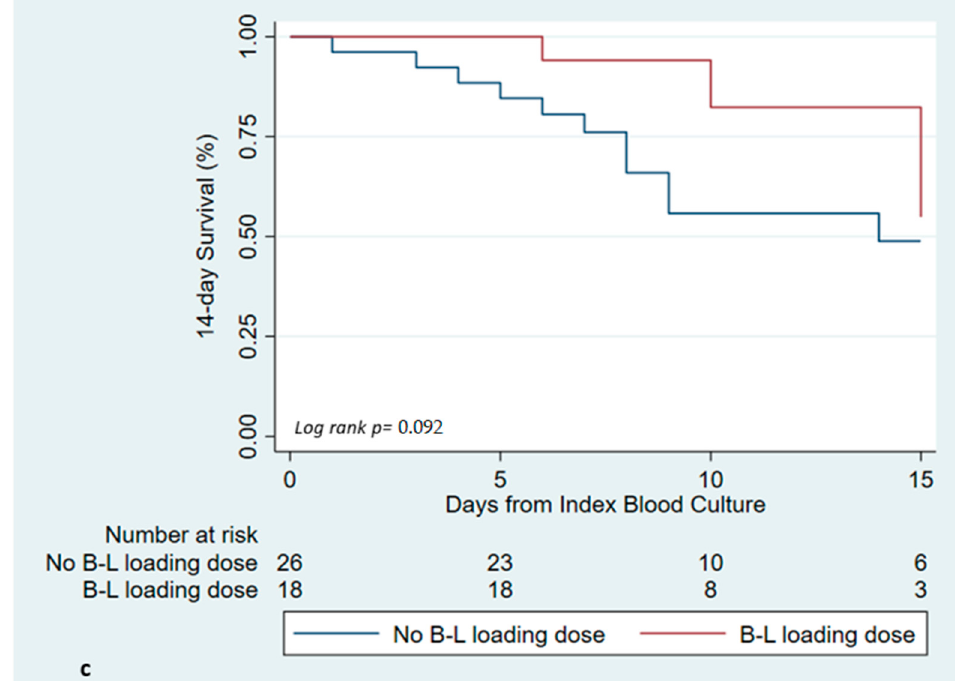
Figure 2. Kaplan–Meier survival curves for 14-day risk of mortality according to ( a ) time from symp- tom onset to targeted therapy; ( b ) mono- or polymicrobial BSI; ( c ) use of Beta-lactam loading dose.